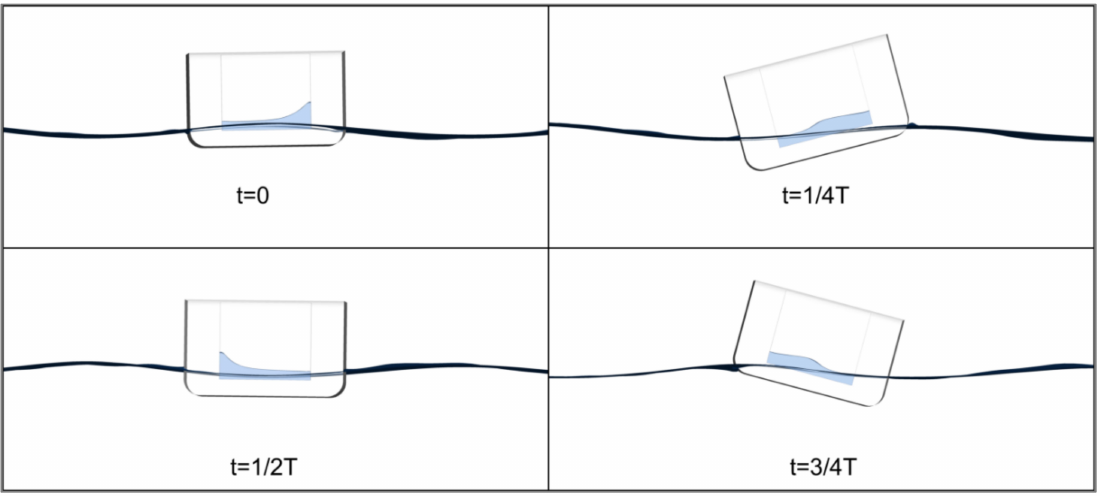
Figure 20. For the ship in beam waves at λ /L = 0.787 with the height of liquid in the tank at 0.1 m, wave-induced ship positions and sloshing-induced surface elevations inside the tank at time steps of